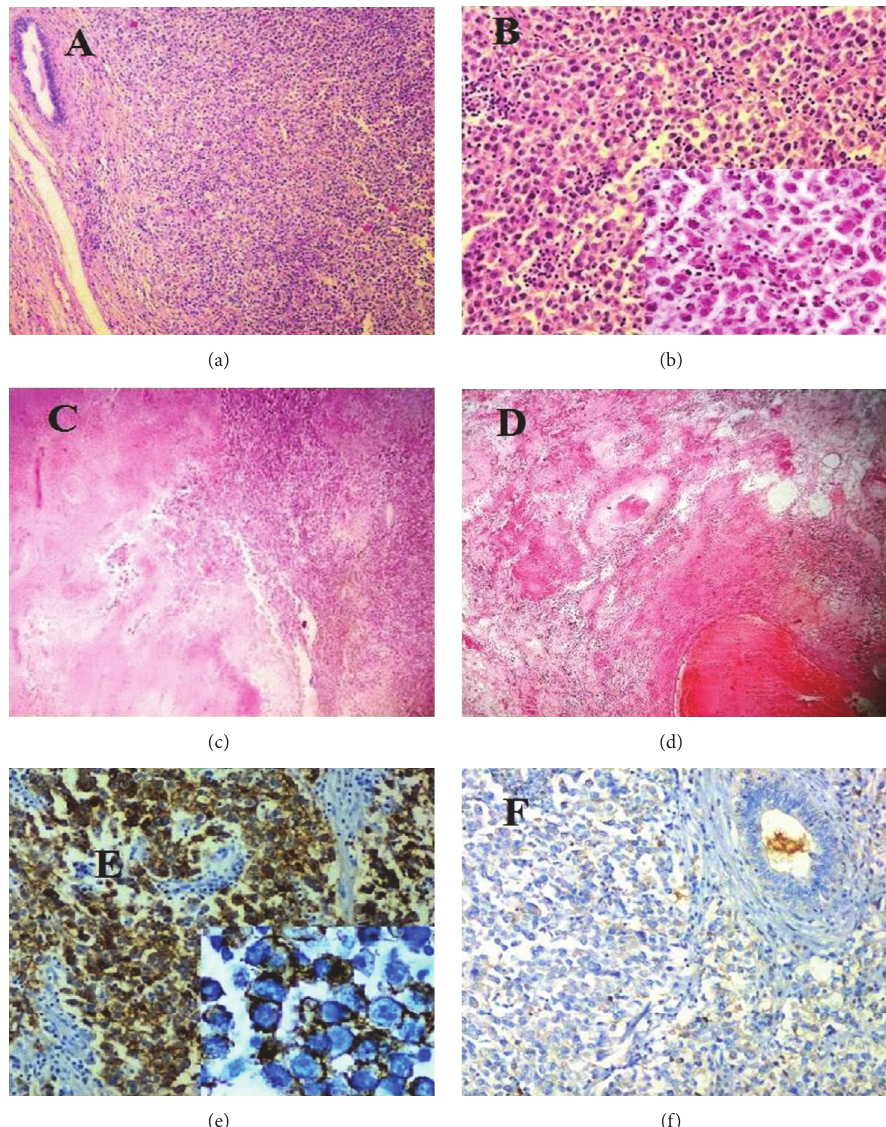
Figure 2: (a) Nests and sheets of tumor cells with a tubule at periphery. H&E, 40x. (b) Tumor cells interspersed with lymphoplasmacytic infiltrate with focal presence of pleomorphic cells. H&E, 100x. (c & d) Areas of hemorrhage, necrosis, and cystic change. (e) Tumor cells positive for CD117 and (f) negative for